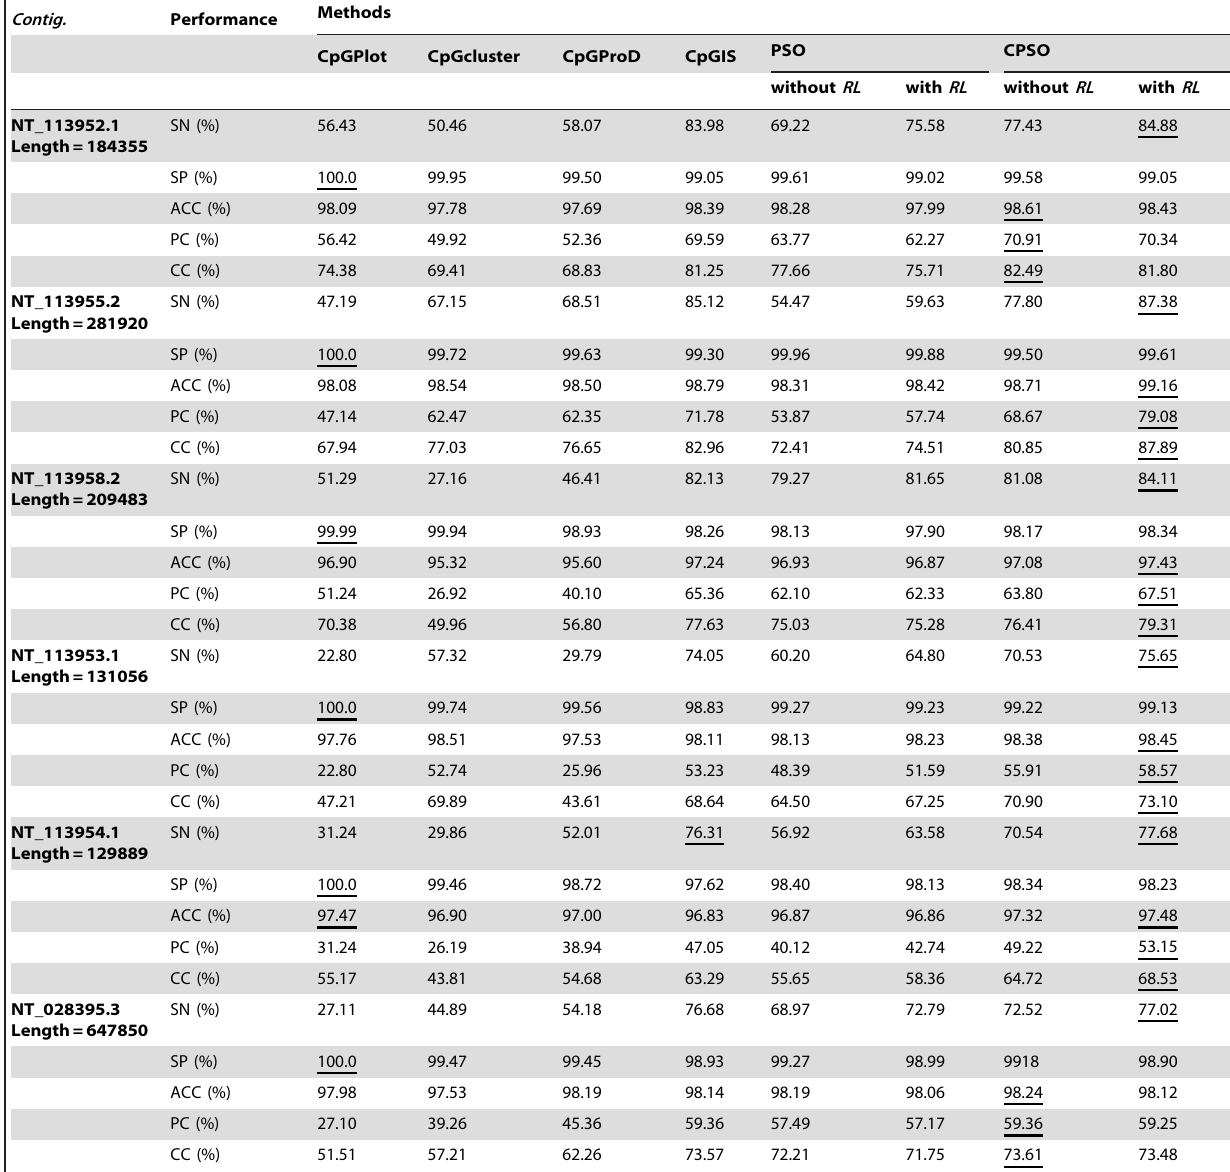
Table 1. Comparison of different methods for CpG island prediction.